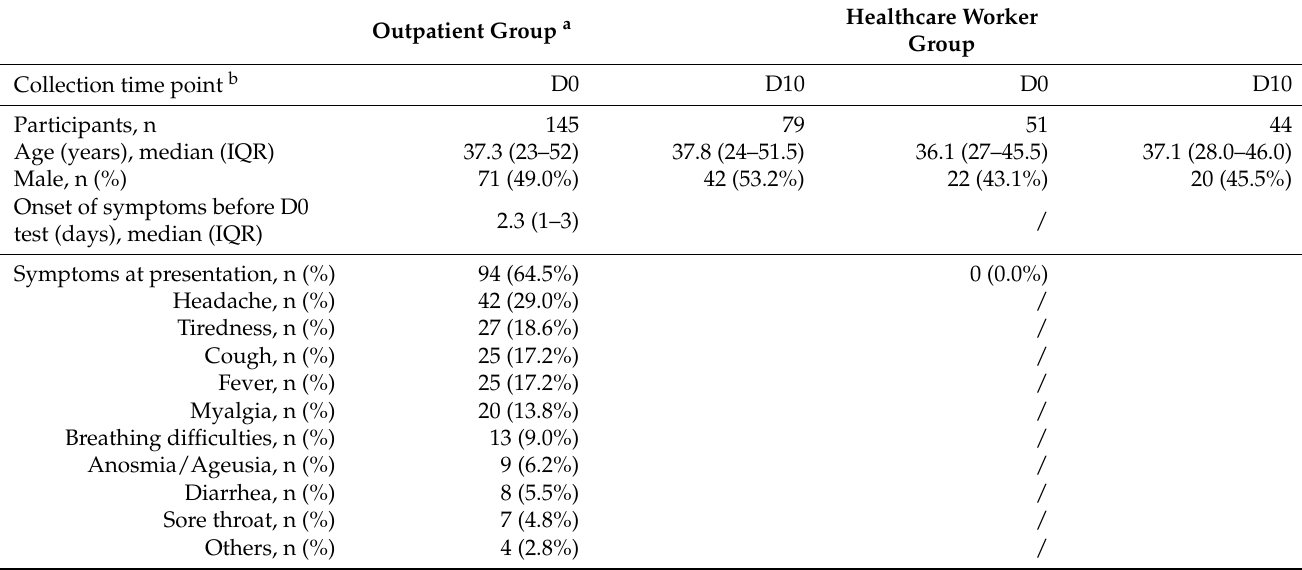
Table 1. Characteristics of participants investigated in this